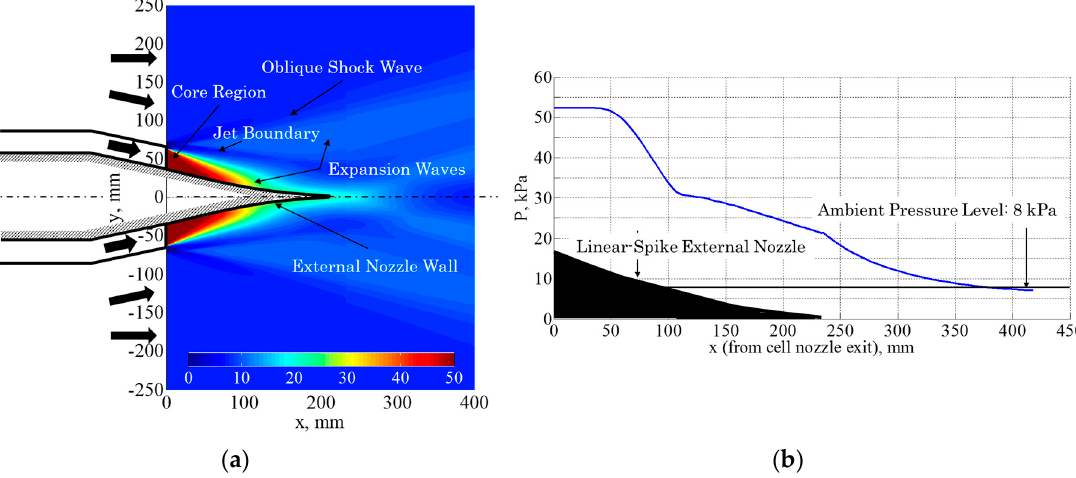
Figure 15. Mesh grids used for calculation of the flowfield of the advanced configuration. The flow direction is from left to right. The region of interest for computation is the area indicated by the grid.